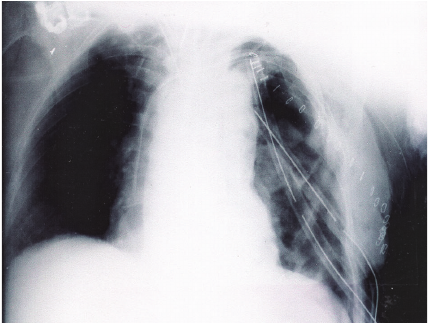
Figure 3: The postoperative chest X-ray showing reexpansion of the left lung.